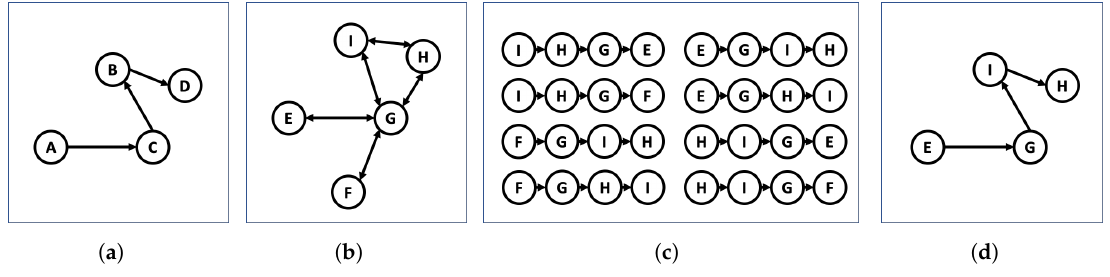
Figure 1. Example run of the CERT algorithm. ( a ) shows G ( P ) , ( b ) shows instead G ( I ) . The clique generation, pictured in ( c ) finds all the subgraphs of of length N = 4 according to the length of G ( P ) . The detection step is shown in ( d ), where we find the best possible match of G ( P )